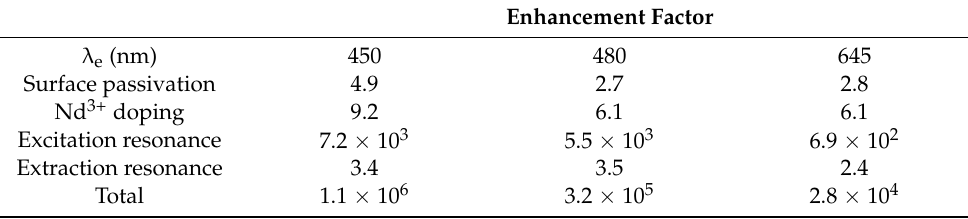
Table 1. Comparison of enhancement factors obtained at the emission wavelengths ( λ e ) 450, 480, and 645 nm of the Tm 3+ − doped UCNPs using the different strategies reported in this